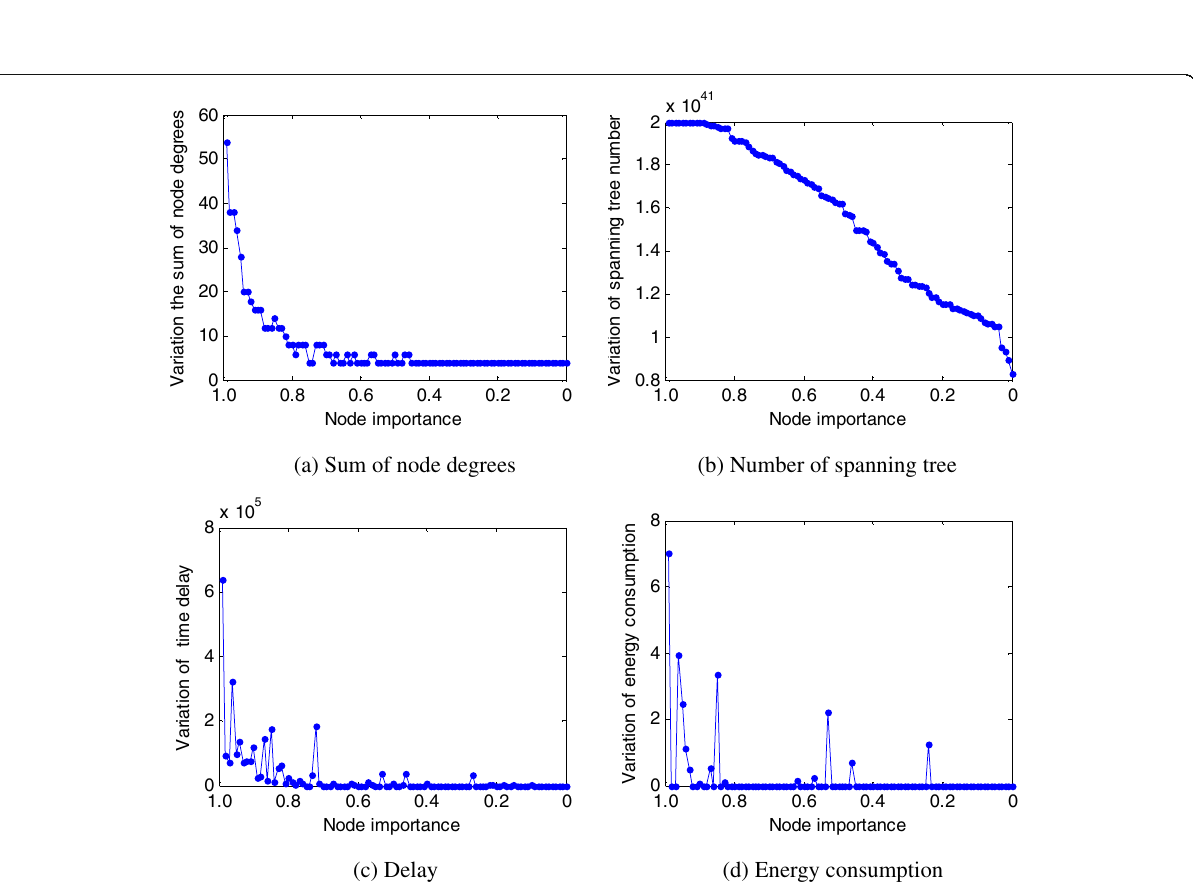
Fig. 5 Changes in the four indicators. The changes in the four indicators of the key nodes, and the influence of four indicators on the node importance. a Sum of node degrees. b Number of spanning tree. c Delay. d Energy